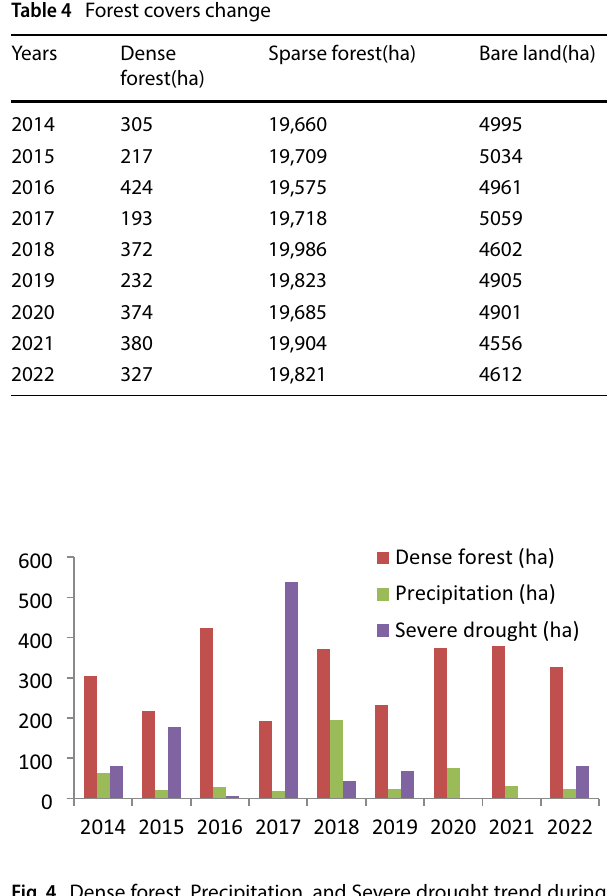
Fig. 4 Dense forest, Precipitation, and Severe drought trend during the study